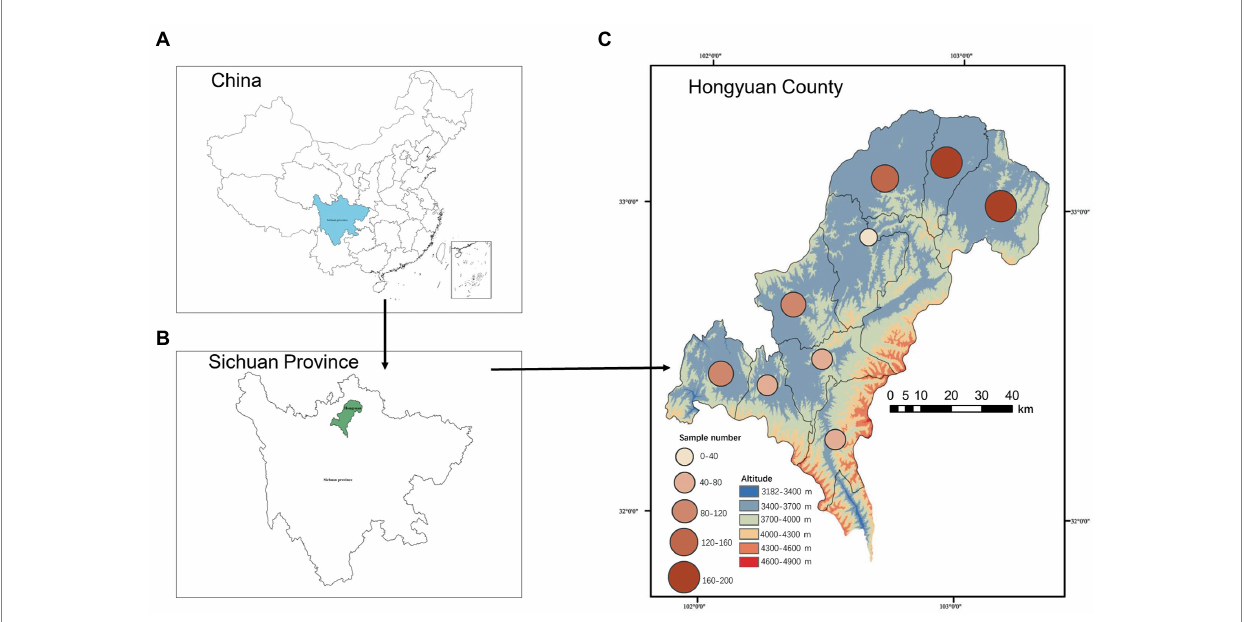
FIGURE 2 Location map of the study area. (A,B) Show the location of research area in the maps of China and Sichuan Province, respectively. (C) Shows the location of nine villages in the maps of Hongyuan County. For (A) , the blue area shows the location of Sichuan province in China. For (B) , the green area shows the location of Hongyuan County in Sichuan Province. For (C) , the size of the circle represents the number of interview samples.